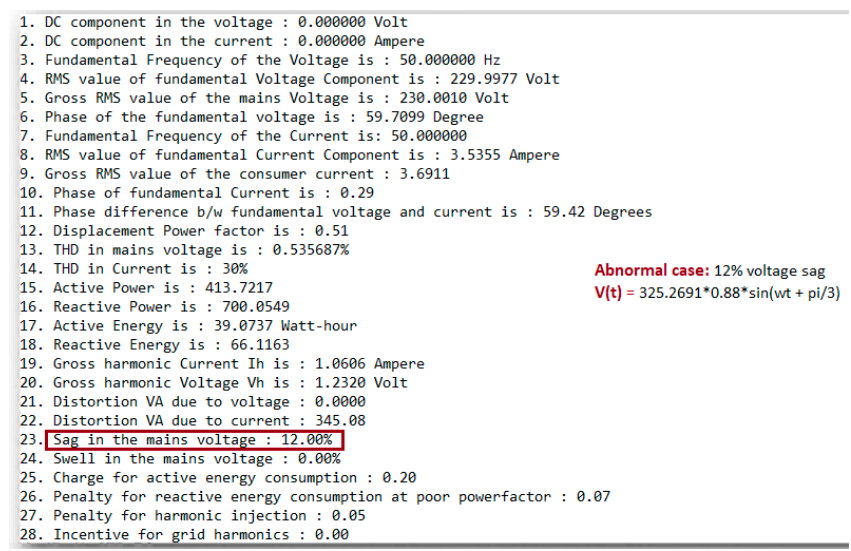
Figure 10. Display of 28 PQ parameters.